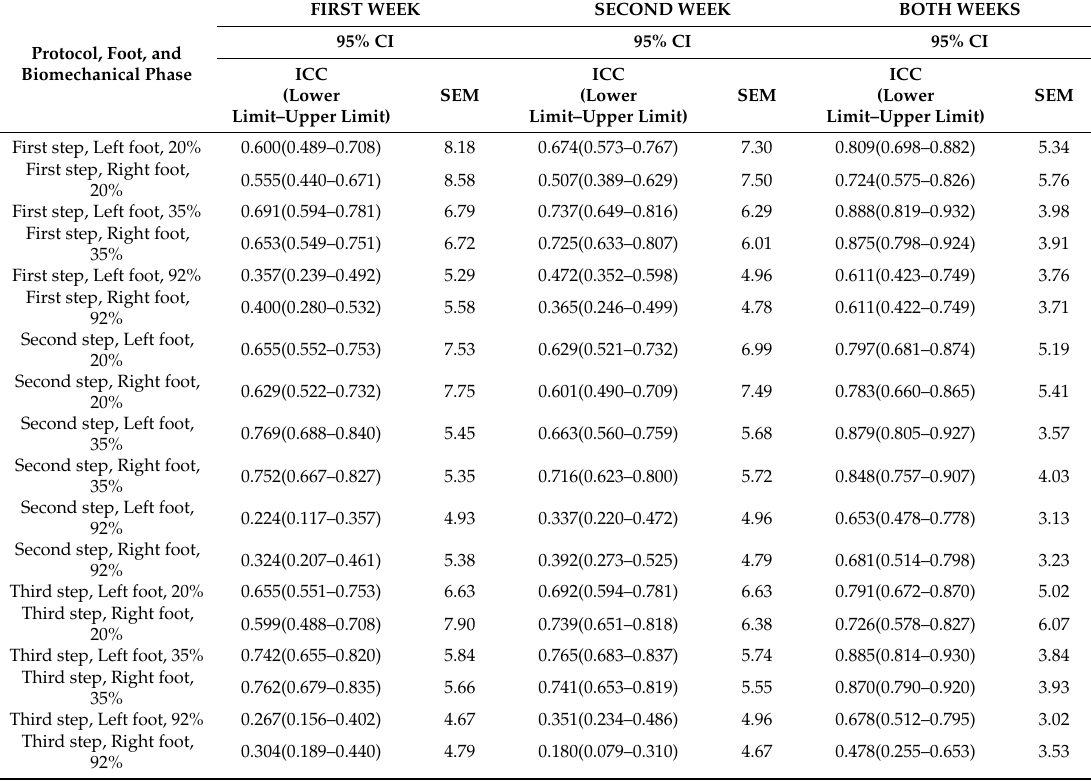
Table 2. Intra-class correlation coe ffi cient (ICC) and standard errors of the mean (SEM) for Contact Surface Areas,